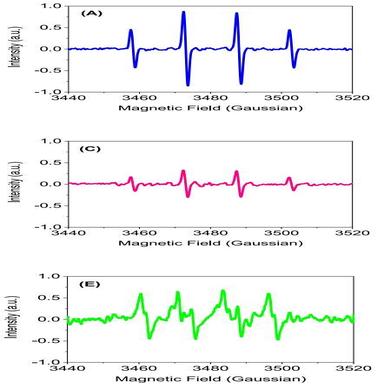
EPR spectra of irradiated (λem ca. 352 nm) aqueous DMPO (10 mM) suspensions in the following media: in the presence of Ti-γAl2O3 (A); in the presence of Ti-γAl2O3 and CHL (0.1 M) (B); in the presence of Ti-γAl2O3 and TBA (0.1 M) (C); in the presence of TiγAl2O3 and FFA (0.1 M) (D). EPR spectra of irradiated (50 W HBO lamp using a 320 nm cut-off filter) suspensions of DMPO (10 mM) in DMSO in the following media: in the presence of γAl2O3 (E); in the presence of Ti-γAl2O3 (F). 1 mg/mL of the photocatalyst was